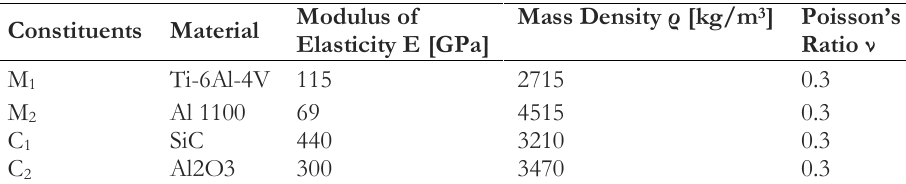
Table 6. The properties of material constituents for the 2D-FG layer.